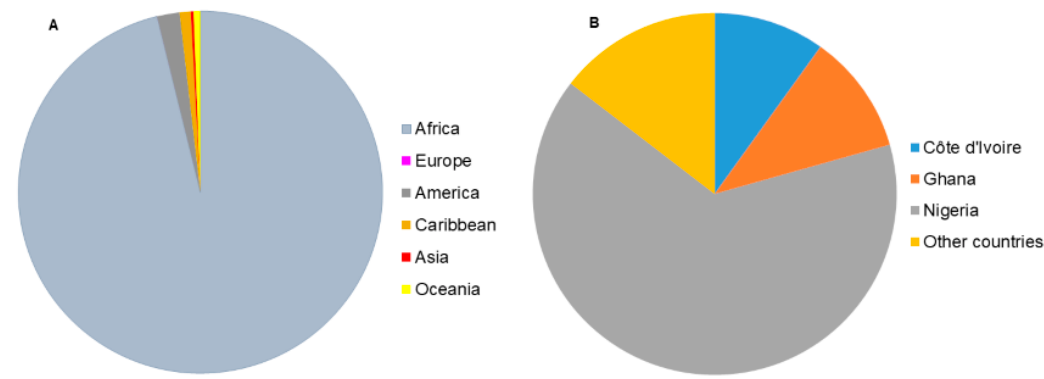
Figure 1. ( A ) Global distribution of yam production in 2018 (Africa 96.2%, America 2.0%, Caribbean 1.0%, Oceania 0.6%, Asia 0.2%, Europe 0%), ( B ) Top yam producing countries in 2018 (Nigeria—65.9%, Ghana–10.7%, Côte d’Ivoire—9.9%, other countries—14.5%) [11].